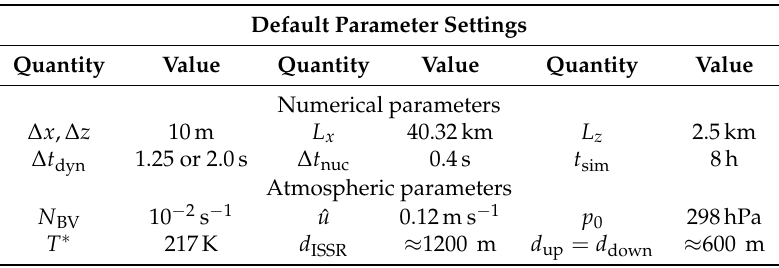
Table 1. Summary of numerical and atmospheric parameters of the simulations. The meaning of the various symbols is explained in the